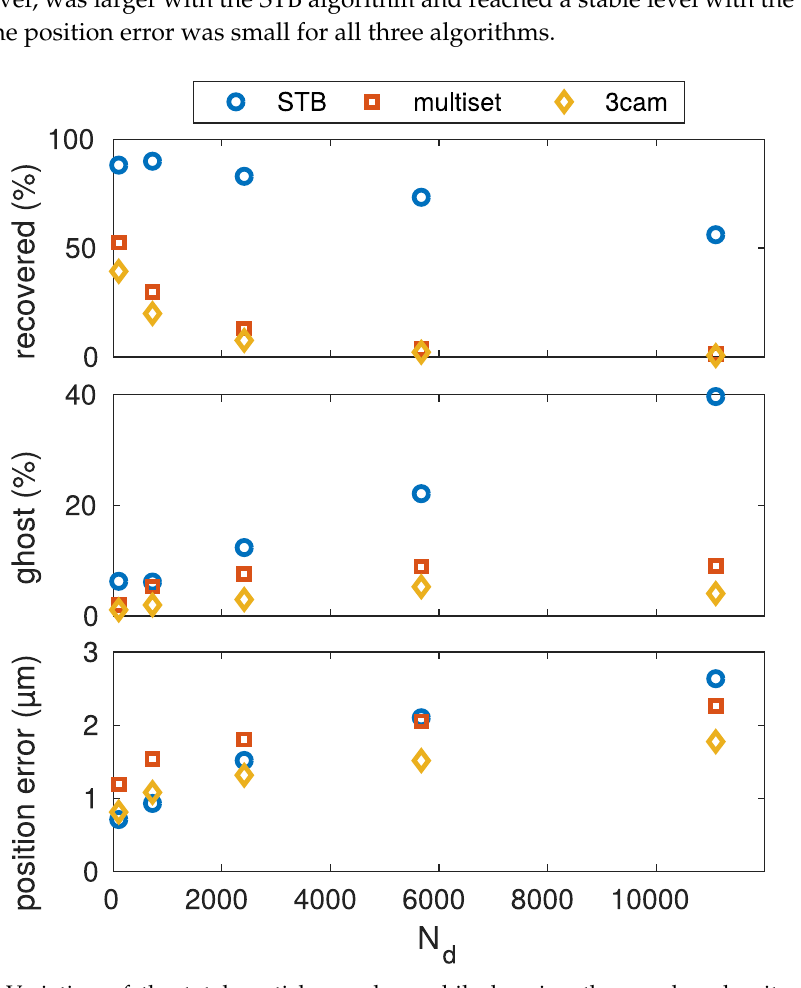
Figure 5. Variation of the total particle number, while keeping the number density constant. The constant number density is comparable to that of a microgravoty